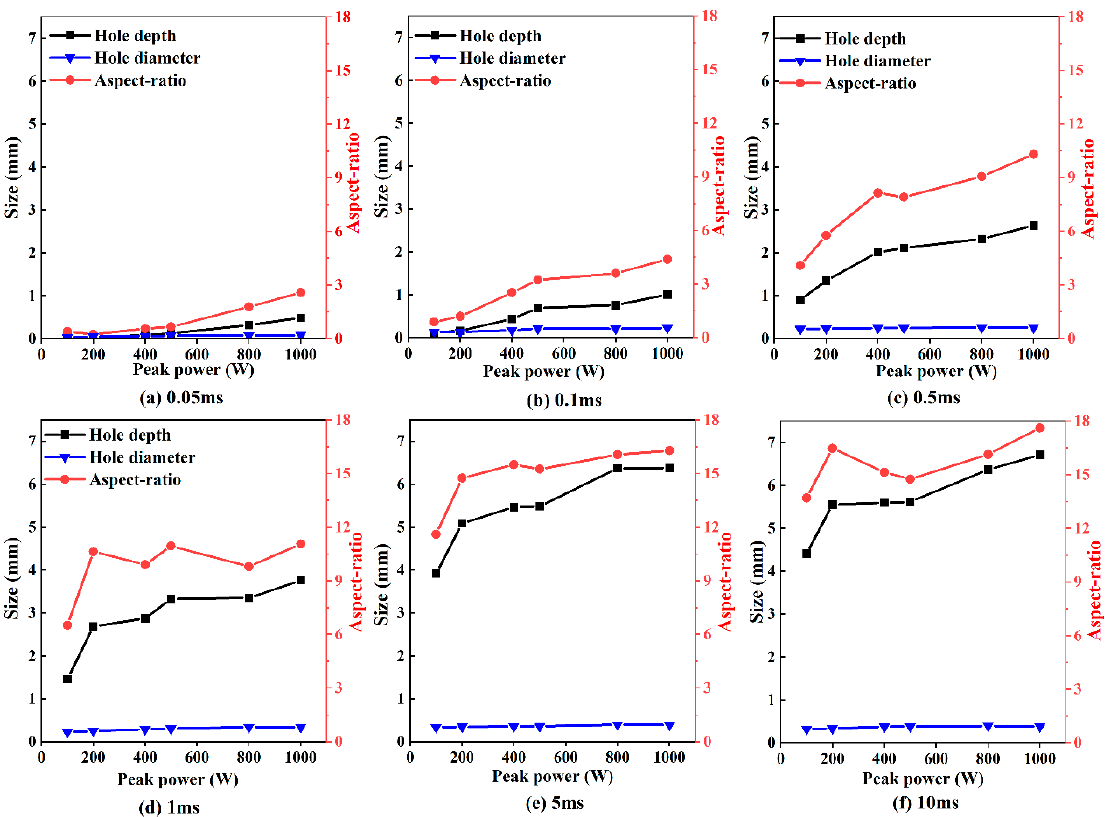
Figure 4. Hole depth, hole diameter, and aspect ratio under different peak powers with pulse widths of ( a ) 0.05 ms, ( b ) 0.1 ms, ( c ) 0.5 ms, ( d ) 1 ms, ( e ) 5 ms, and ( f ) 10 ms.